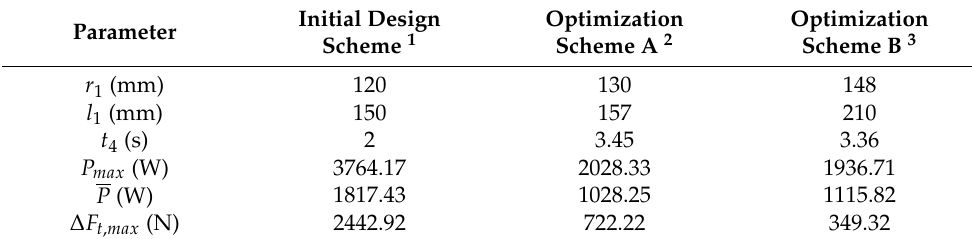
Table 1. Results of the multi-objective optimization of the load-related parameters.